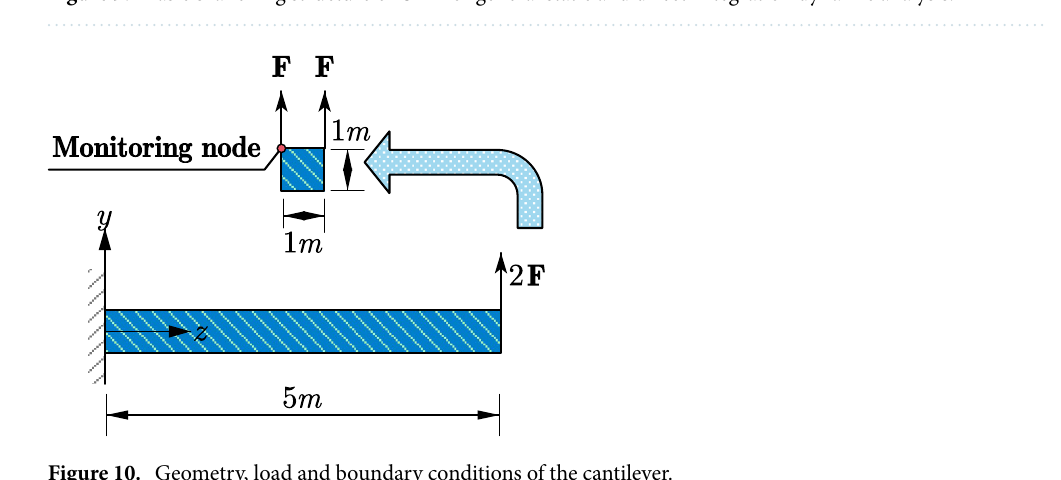
Figure 9. Basic branching structure of UEL for general static and direct-integration dynamic analysis.